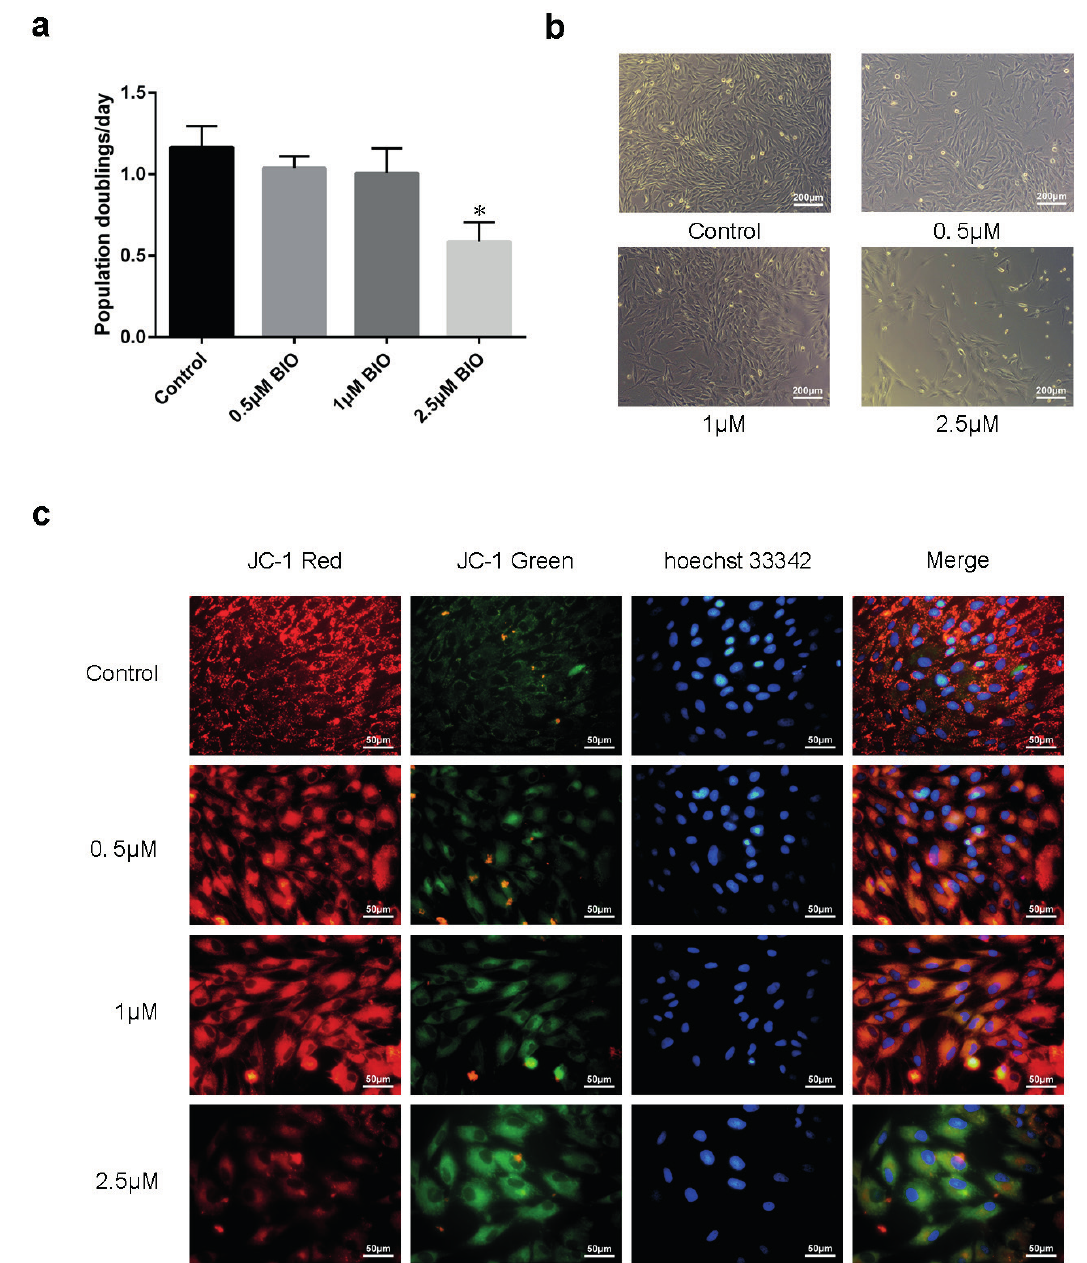
Figure 2 - Effect of BIO on morphology, proliferation and mitochondrial transmembrane potential of canine BMSCs. Control: osteogenic medium; 0.5, 1.0 and 2.5μM BIO: osteogenic medium containing 0.5, 1.0 and 2.5 μM BIO. ( a ) Effect of BIO on proliferation of canine BMSCs. (n = 3). Error bars denote mean ± SD. *P < 0.05. ( b ) The morphology and proliferation of canine BMSCs grown for 4 days different medium as indicated. ( c ) Changes in the mitochondrial transmembrane potential of canine BMSCs grown for 4 days different medium as indicated. The red fluorescence (polymer) and green fluorescence (monomer) of canine BMSCs in osteogenic medium with or without BIO. Normally, mitochondria JC-1 use its potential as a red fluorescent emitter to form a polymer. In the destruction of mitochondrial function, JC-1 as a monomer dispersed and distributed in the cytoplasm, was detected as green fluorescence. Hoechst33342: Hoechst33342 staining of the nucleus; Merge: The superposition of red fluorescence (polymer), green fluorescence (monomer) and Hoechst33342 in canine